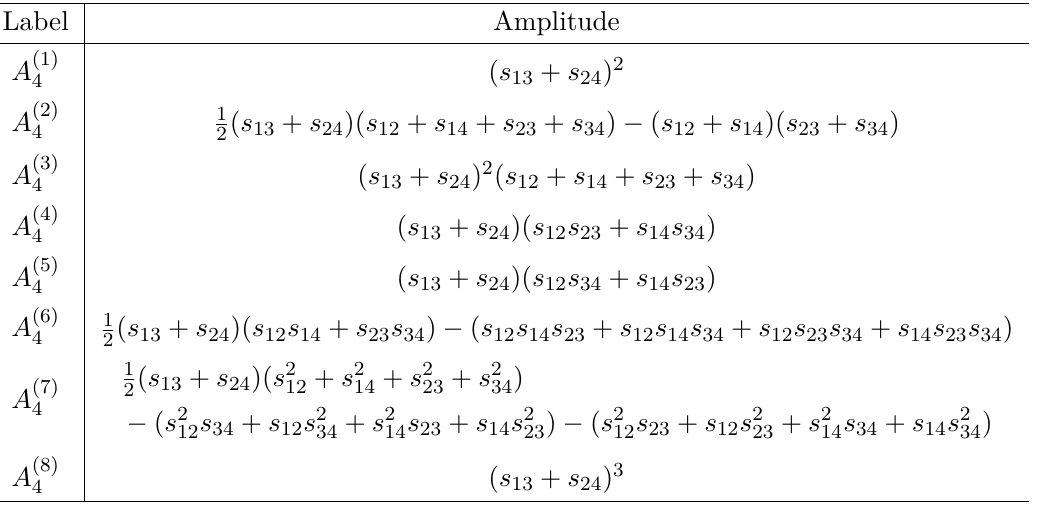
Table 3 . Seed four-point amplitudes in type B 2 theories with soft scaling exponent σ ≥ 2 . The nonrelativistic “Mandelstam variables” s ij are defined by s ij ≡ p i · p j